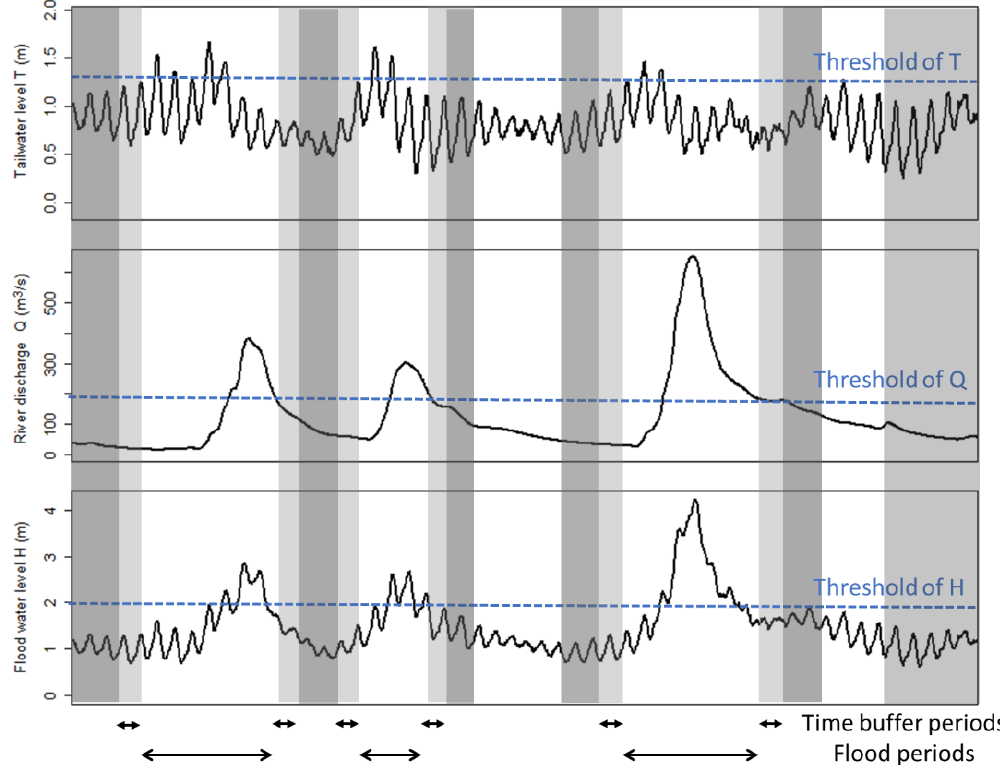
Figure 5. Conceptual illustration of censored continuous simulation for simulating compound flood level H in estuarine regions caused by tailwater level in the ocean T and river discharge Q . The time periods highlighted in dark grey are low-water-level periods, while the remaining time periods are high-water-level periods, which include flood periods and the time